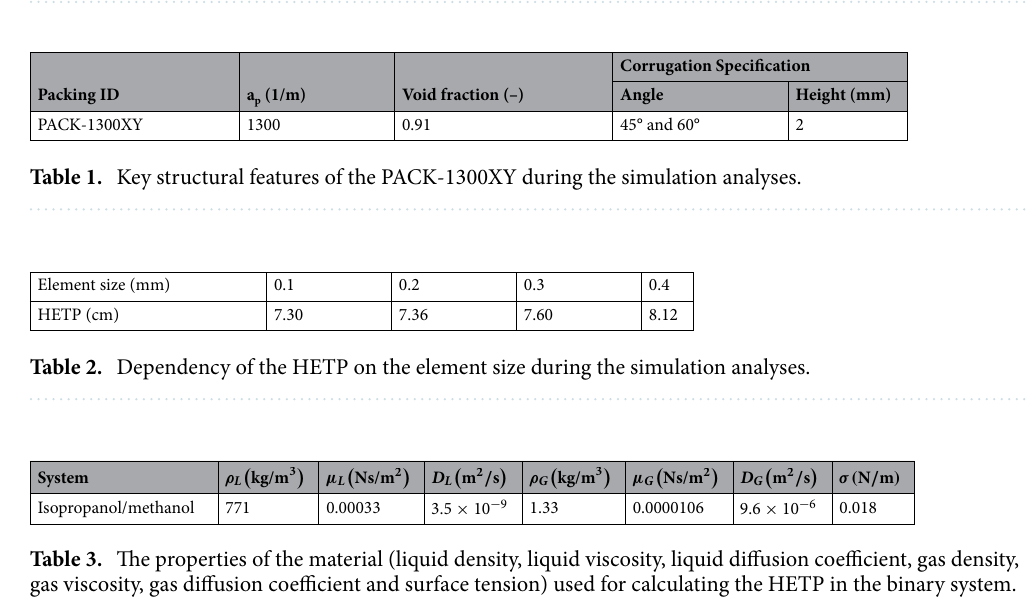
Figure 1. The simulated geometries of the PACK-1300XY.